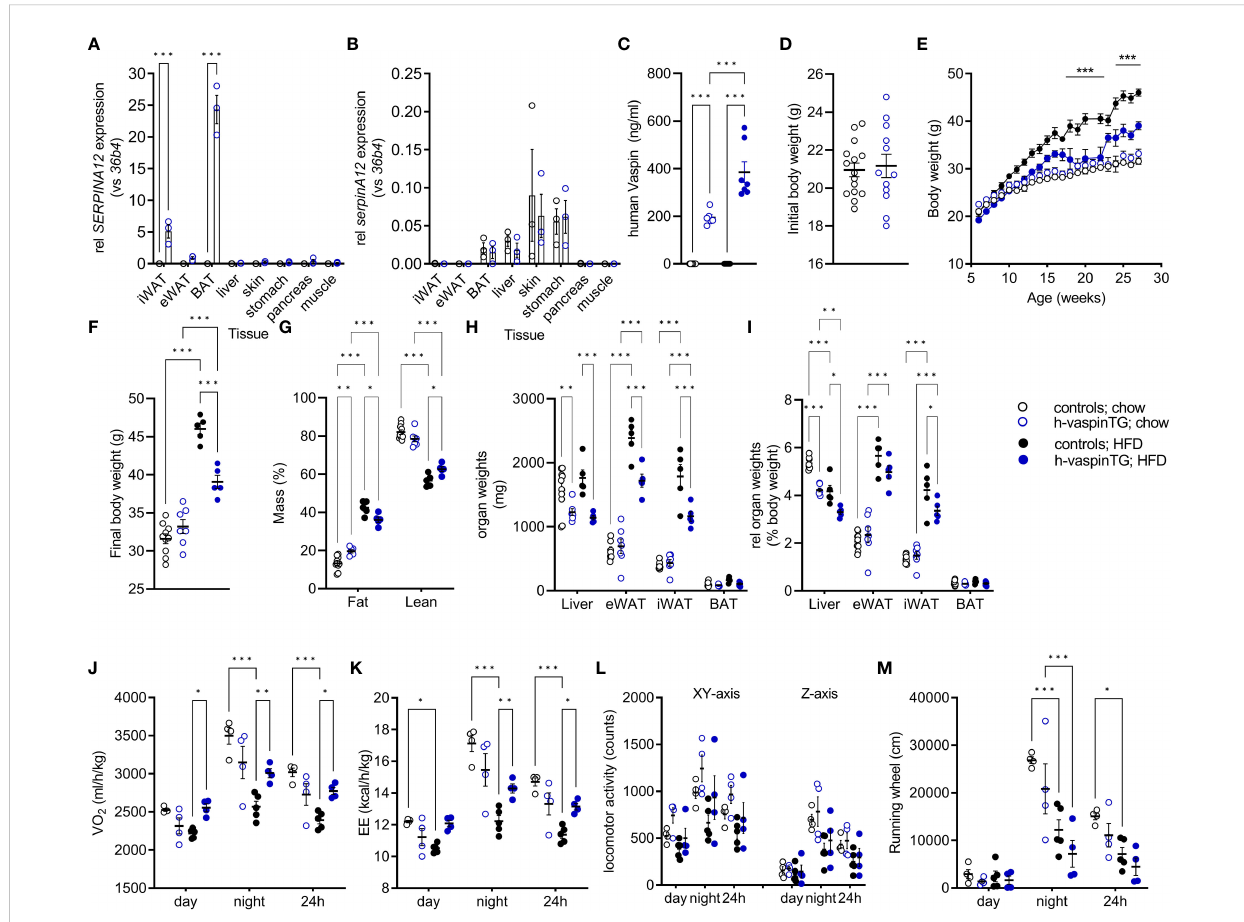
FIGURE 1 Characterization of h-vaspinTG mice and controls under chow and high fat diet (HFD). (A, B) relative mRNA expression of (A) human ( SERPINA12 ) and (B) endogenous ( SerpinA12 ) vaspin in AT depots and peripheral tissues as determined by RT-qPCR (n = 3 per group). Gene expression was normalized to 36b4 . (C) Human vaspin serum concentration (ng/ml) as measured by ELISA (n = 7-10), at the end of the study. (D) Initial body weight, (E) body weight gain and (F) fi nal body weight of h-vaspinTG and control mice fed a chow or a HFD for 29 weeks, starting at the age of 6 weeks (n = 5-10). (G) Percentage of fat mass (%) and lean body mass (%) as determined by EchoMRI at the end of the study (n = 5-10). (H, I) Absolute and relative organ weights of liver, epididymal (eWAT), inguinal (iWAT) and brown adipose tissue (BAT) at the end of the study (n =5-10). (J-M) Indirect calorimetry of h-vaspinTG and control mice under chow and HFD during light and dark phase (n = 4-5 per group). (J) Oxygen consumption (VO 2 in ml/kg/h) and (K) energy expenditure (EE in kcal/h/kg) were recorded over a period of 72 h. (L) Physical activity assessed via locomotor activity as movement in cage (XY-axis), rearing (Z-axis) and (M) running in wheel (cm) were recorded for 72 h (n = 4-5). Data are presented as mean ± SEM. Statistical signi fi cance was calculated by two-way ANOVA followed by S ̌ ida ́ k ’ s (A, B, D) or Tukey ’ s (G-L) post-hoc test or by one-way ANOVA with Fisher ’ s LSD test (C) (*p ≤ 0.05, ** p ≤ 0.01, ***p ≤